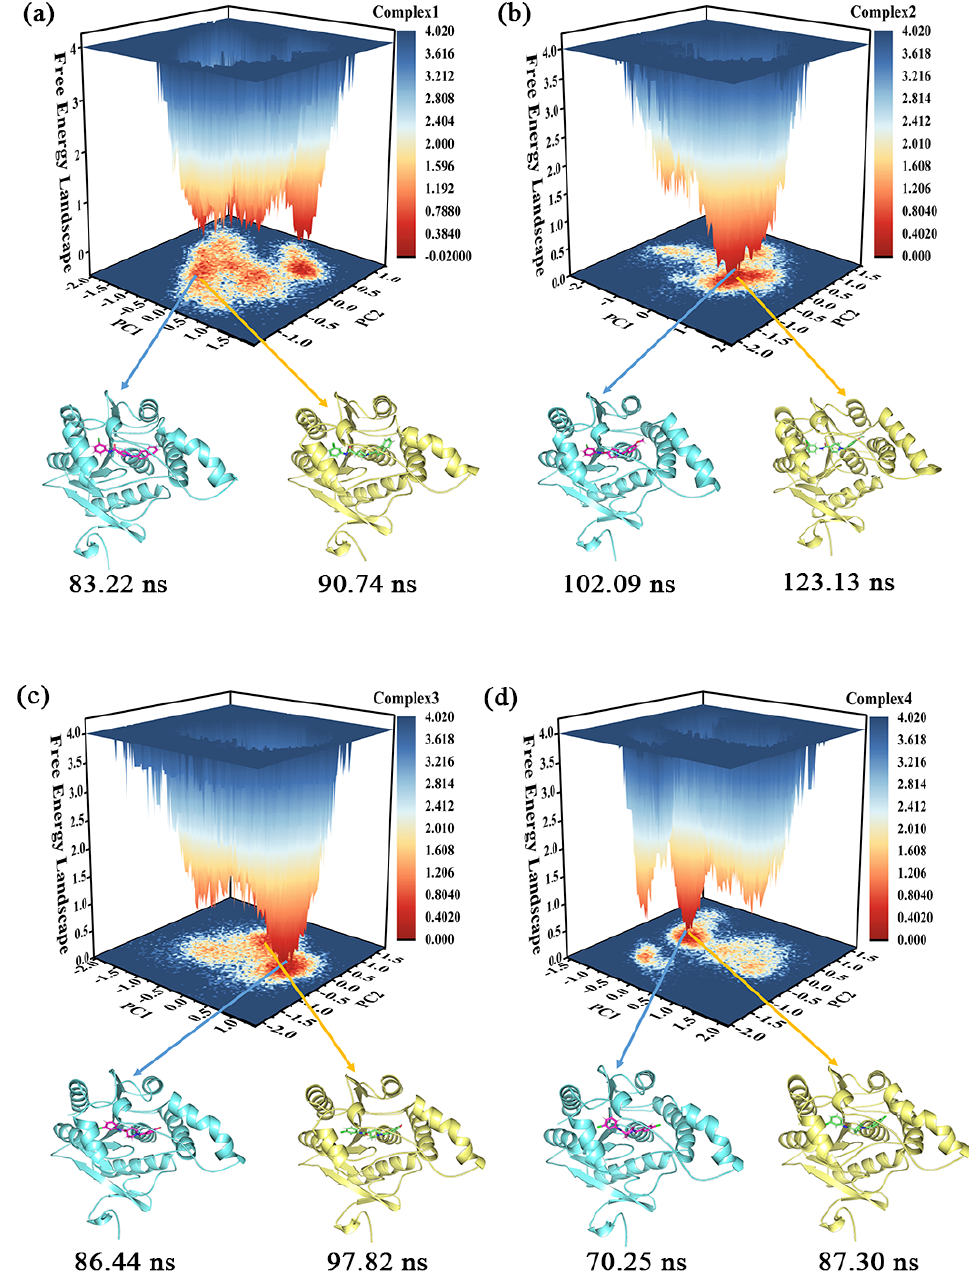
Figure 6. ( a − d ) The free energy landscape of the complexes 1 − 4 and their representative confor- were extracted from the MD simulation mations were extracted from the MD simulation trajectories.